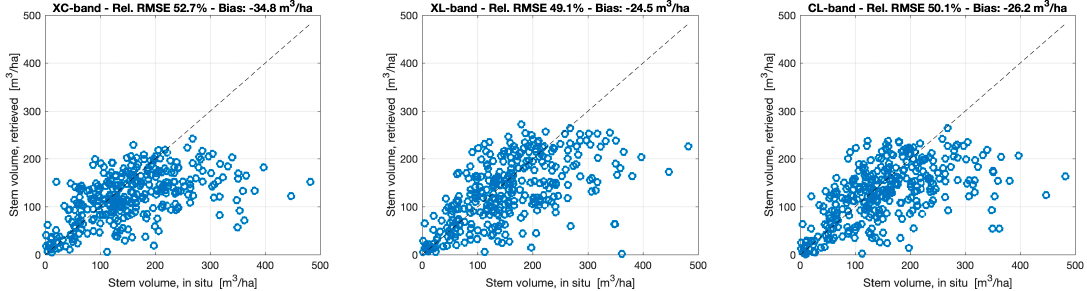
Figure 13. Scatter plots of measured and retrieved stem volume at Krycklan for a combination of estimates obtained from all images acquired at two frequency bands.